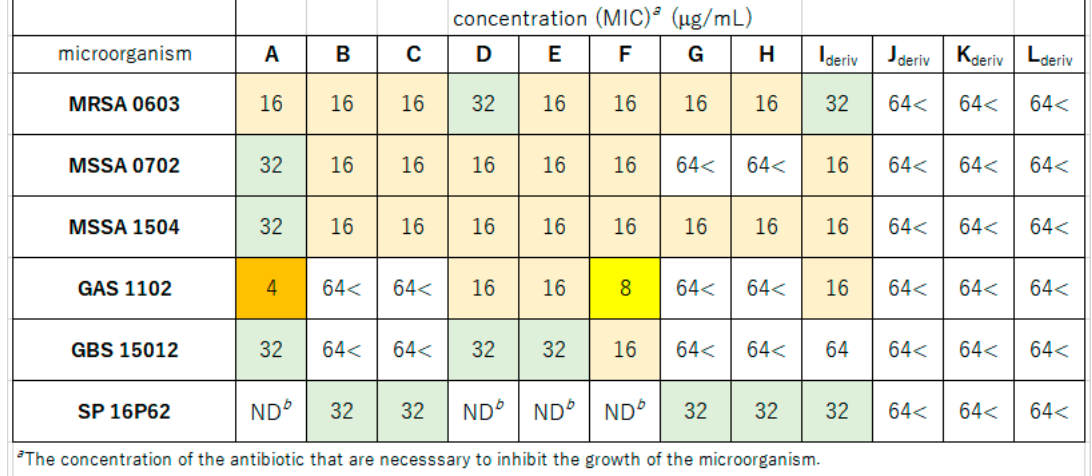
Figure 3. Antifungal activity of eushearilide congeners A – H and I deriv .